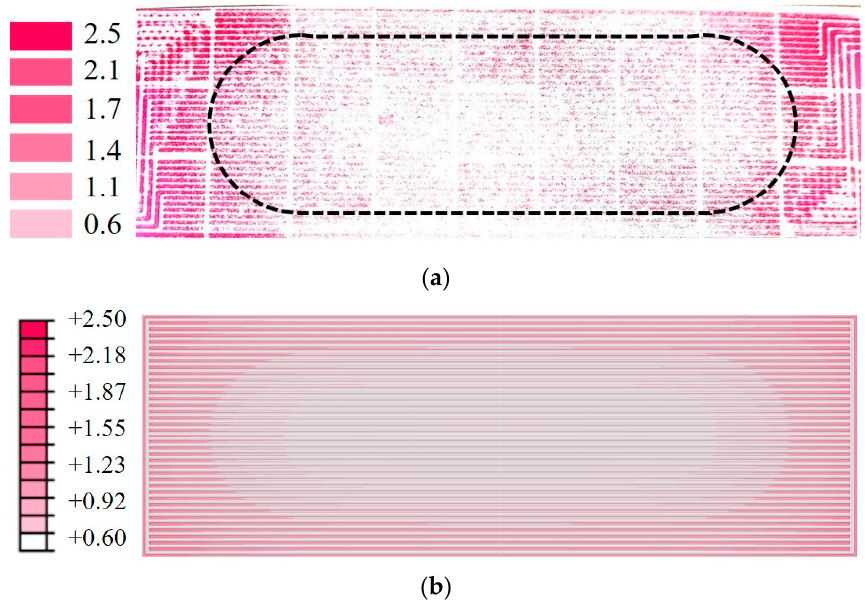
Figure 7. Comparison of contact pressure between ( a ) experiment and ( b ) FE simulation.